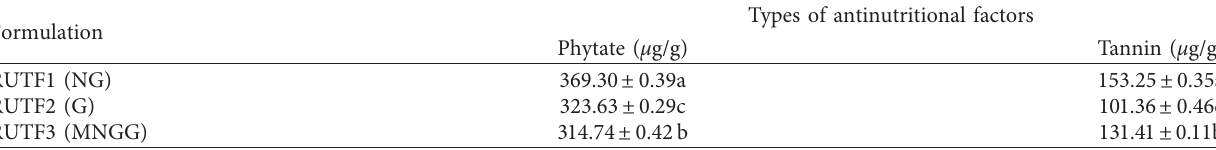
Table 3: Anti-nutritional factors of ready-to-use therapeutic foods.